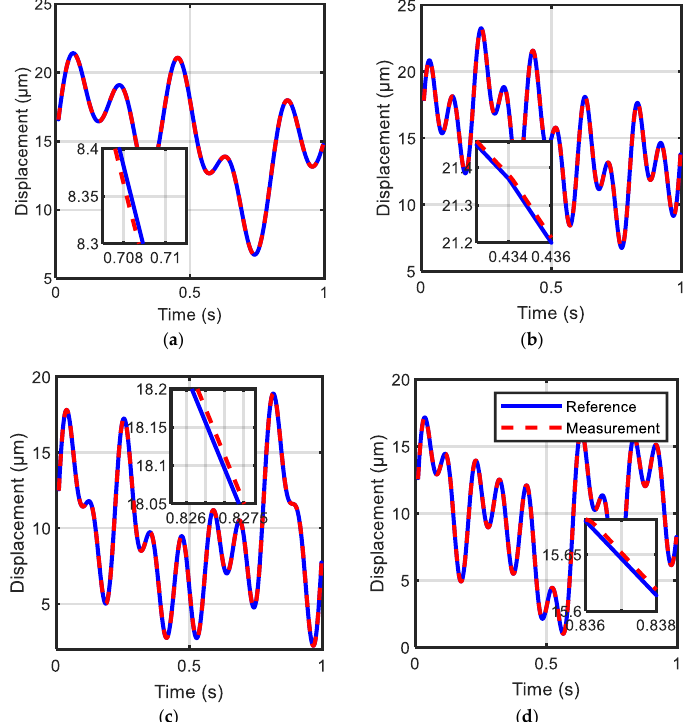
Figure 16. Experimental results of reference tracking in a closed loop with RST control and LSSVM compensation corresponding to: ( a ) test reference H; ( b ) test reference I; ( c ) test reference J; and ( d ) test reference K.